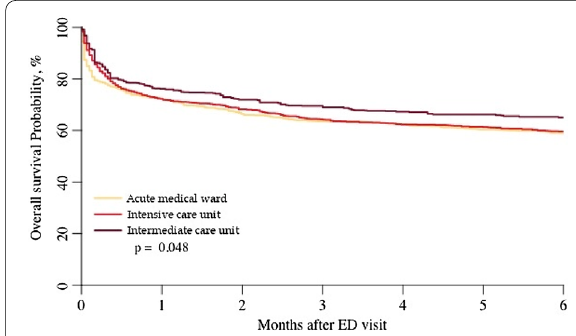
Fig. 1 Adjusted 6-month overall survival according to ward destination in older critically ill patients